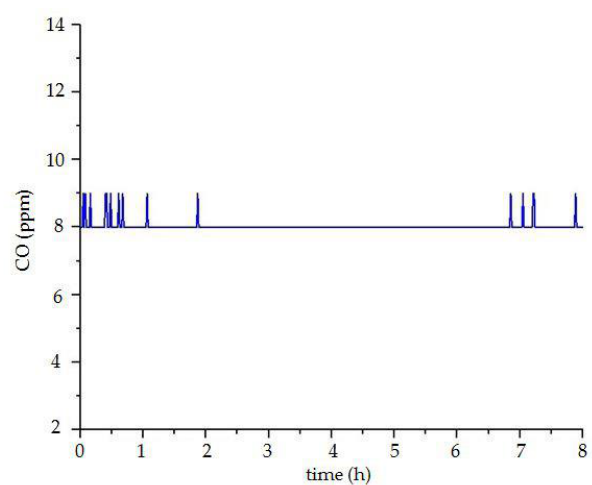
Figure 23. The curve of vibration and toxic gas.